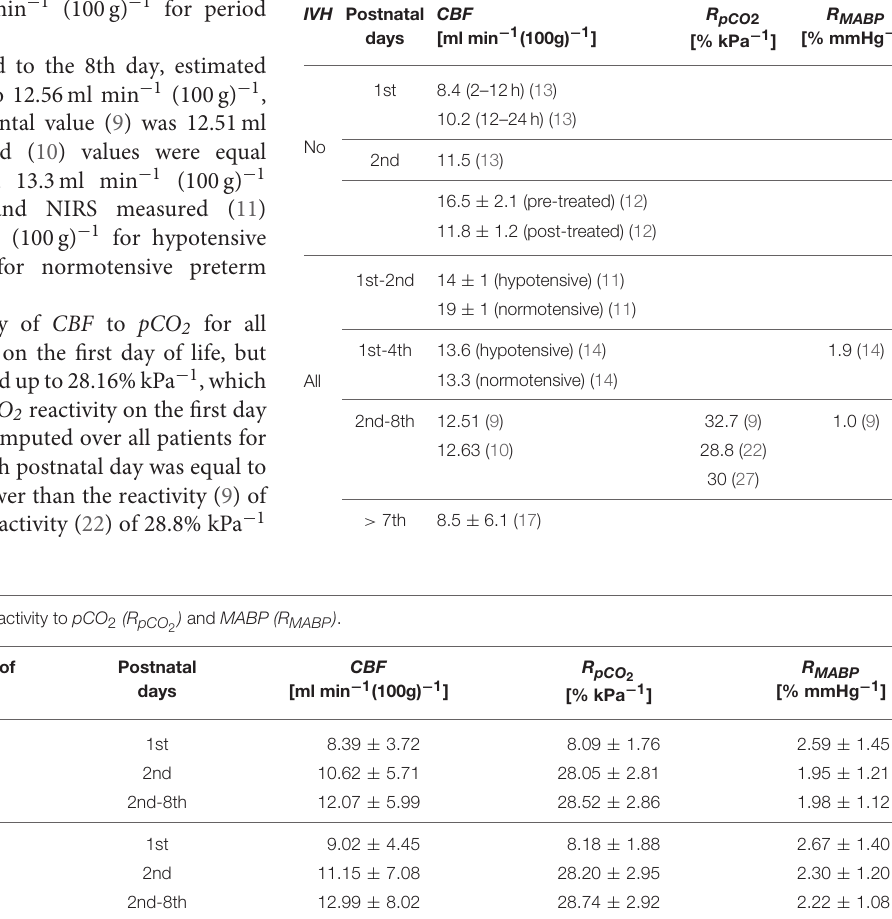
TABLE 6 | Experimental values of CBF and its reactivity to pCO 2 (R pCO 2 ) and MABP (R MABP ) taken from the literature (9–14, 17, 22, 27).